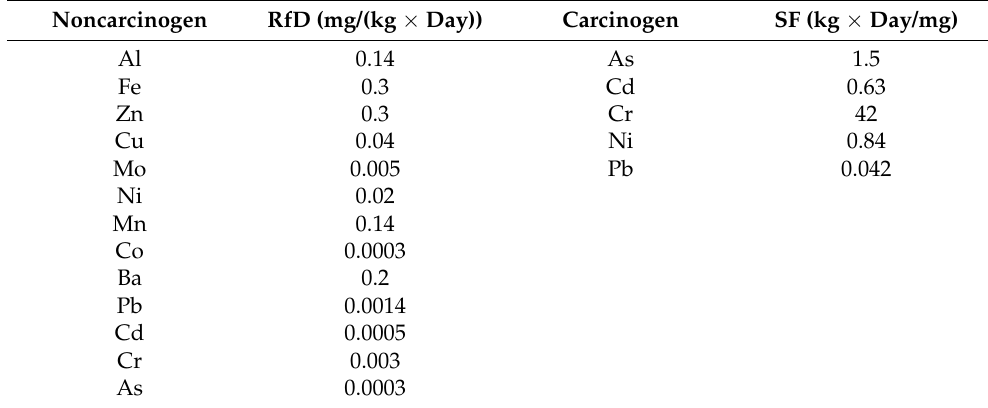
Table 1. Standard values of RfD and SF in the study [46,47]. Table 1 is recreated by the authors.